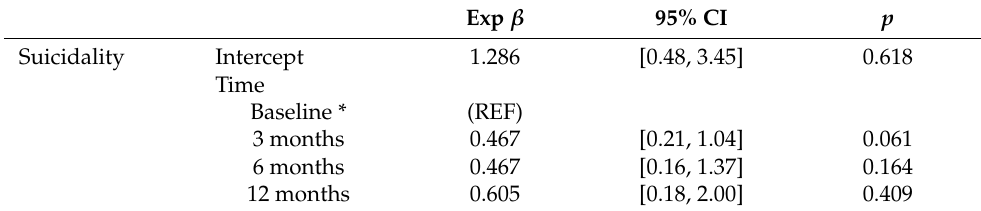
Table 2. General Estimating Equation Statistics for Suicidality.